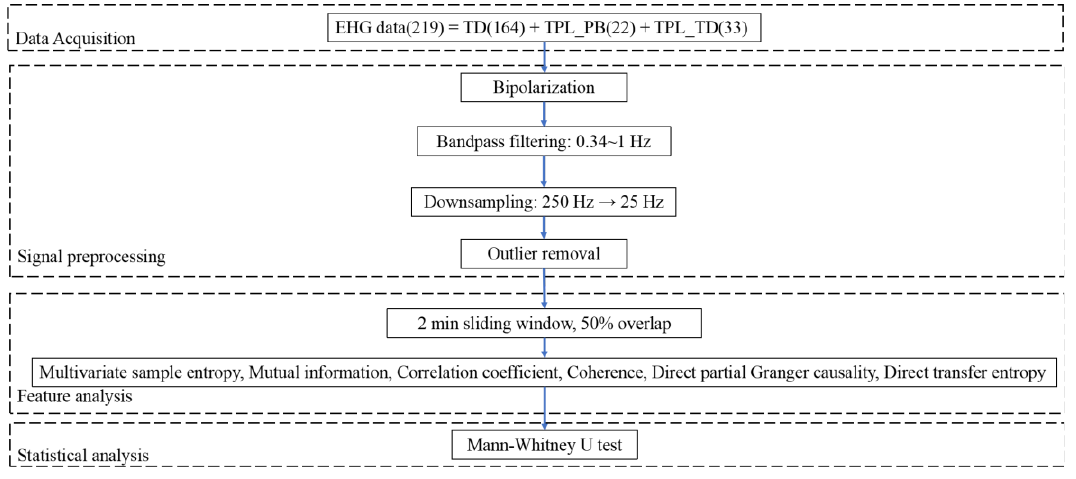
Figure 1. Flow chart of the proposed method.